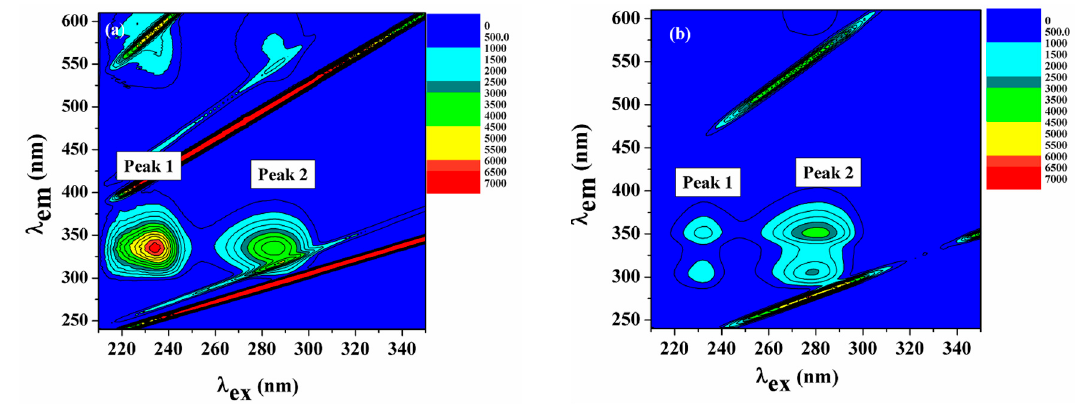
Figure 10. Contour plot of the fluorescence intensity spectra of BSA ( a ) compound 3 -BSA system ( b ). Table 3. Parameters of the 3D fluorescence for compound 3 -BSA binding.